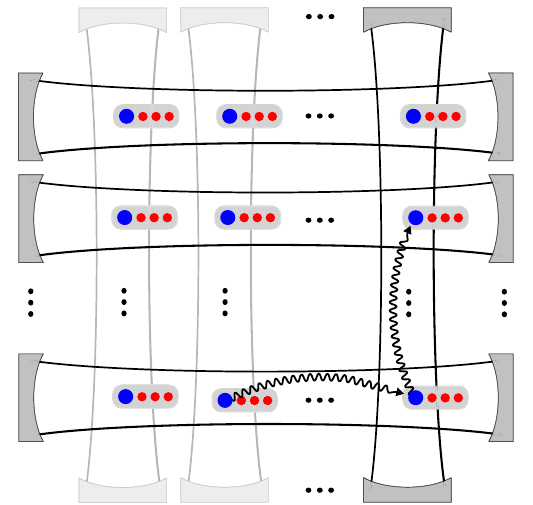
FIG. 6. Extension to larger systems. The methods outlined here could be extended using several overlapping cavity modes, creating systems with potentially 10 4 all-connected qubits. Sev- eral vertical cavity modes (shaded) provide parallelization, such that many photon transfers can be accomplished